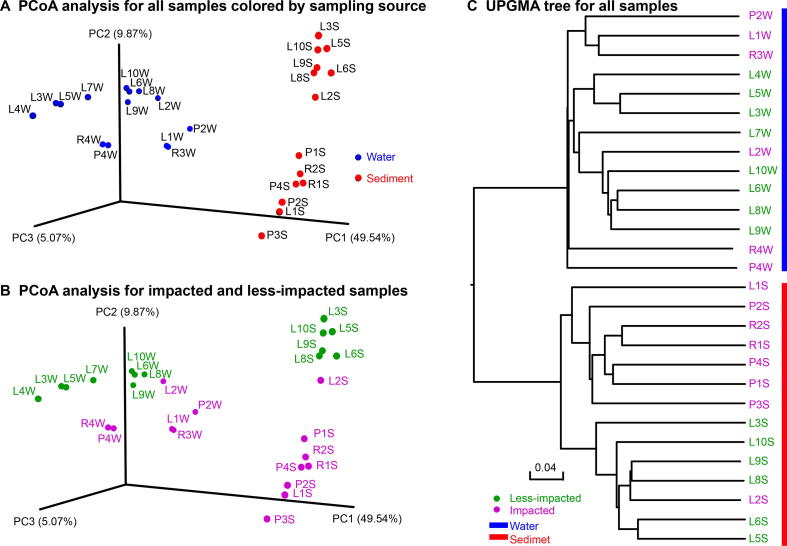
PCoA plots and UPGMA-based clustering of water and sediment microbial communitiesUnweighted UniFrac dissimilarity matrix scores for all samples were visualized in a PCoA plot to demonstrate the dissimilarity of the microbial community structure between samples by sampling medium, water vs. sediment (A) and by sampling location, impacted and less-impacted (B). C. UPGMA-based clustering tree of microbial communities using an unweighted UniFrac distance matrix. The green and pink fonts represent less-impacted and impacted groups, respectively. The blue and red bars mark water and sediment samples, respectively. Samples are named according to the sampling sites (see Figure 1B) with postfixes W and S for water and sediment, respectively.